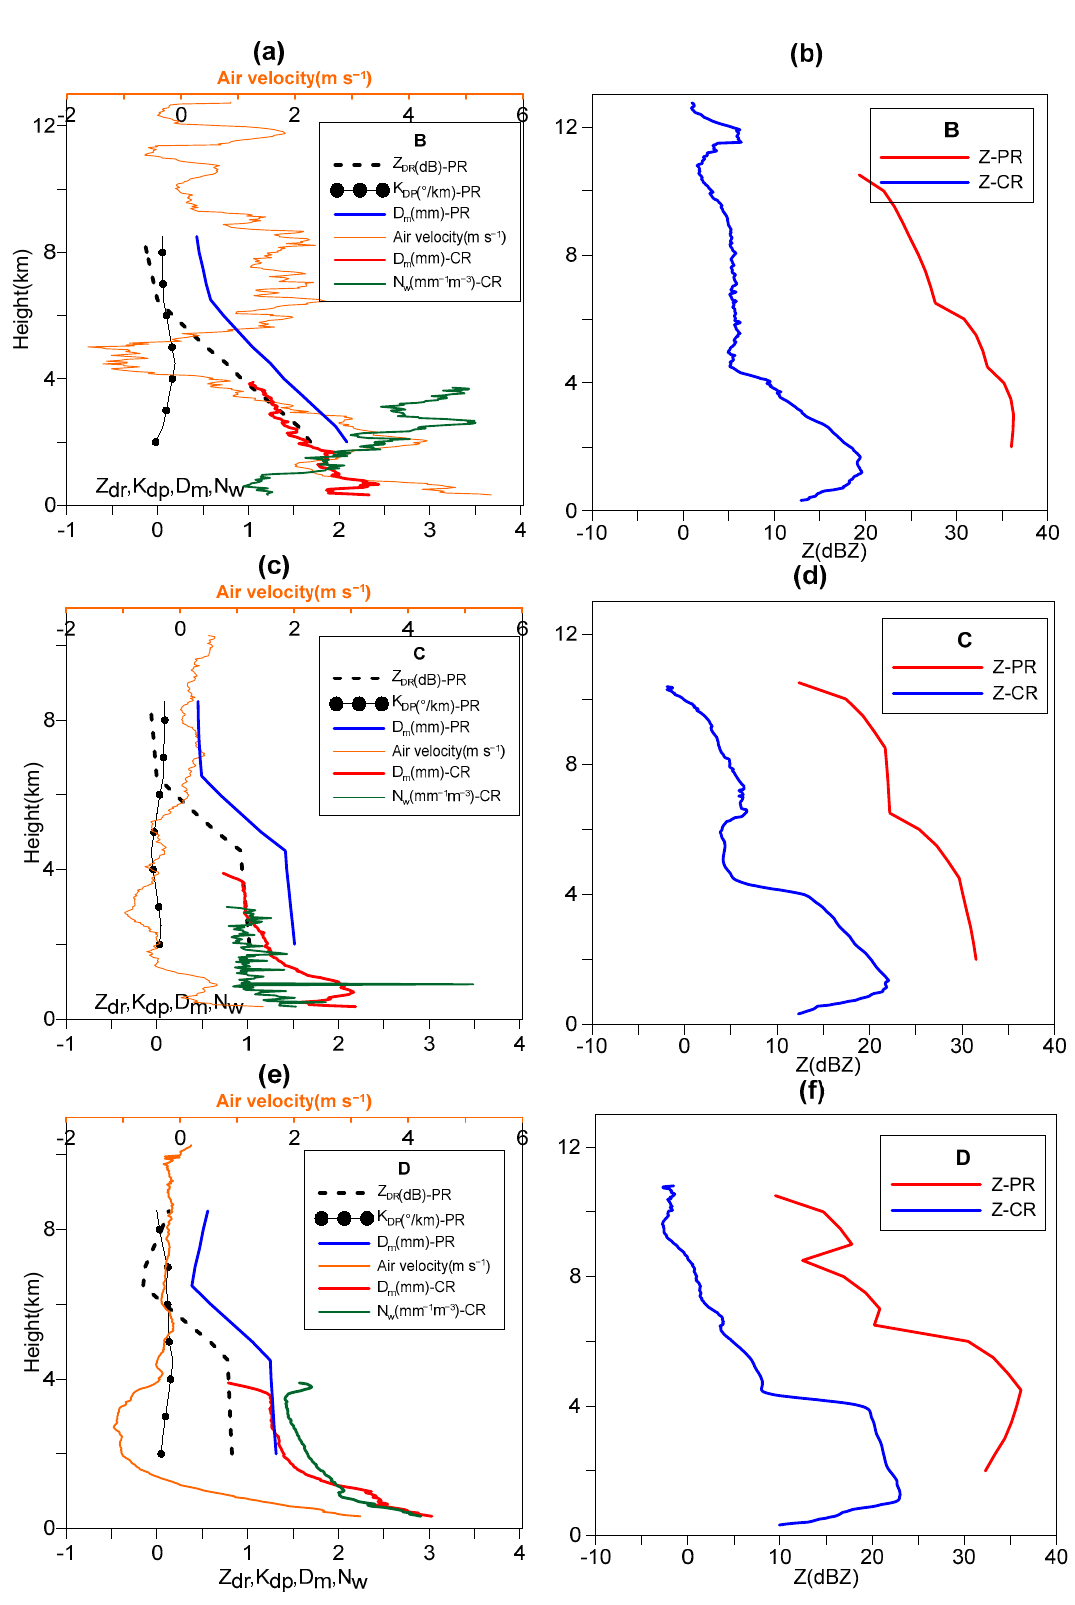
Figure 7. The average profiles of several quantities in segments B, C, and D, including the reflectivity factor, polarization parameters of PR, vertical air velocity, and DSD parameters by CR. ( a , c , e ) show the Z dr , K dp , D m , vertical air velocity, and N w profiles of segments B, C, and D, respectively, and ( b , d , f ) show the reflectivity factor profiles of PR and CR in regions B, C, and D, respectively.